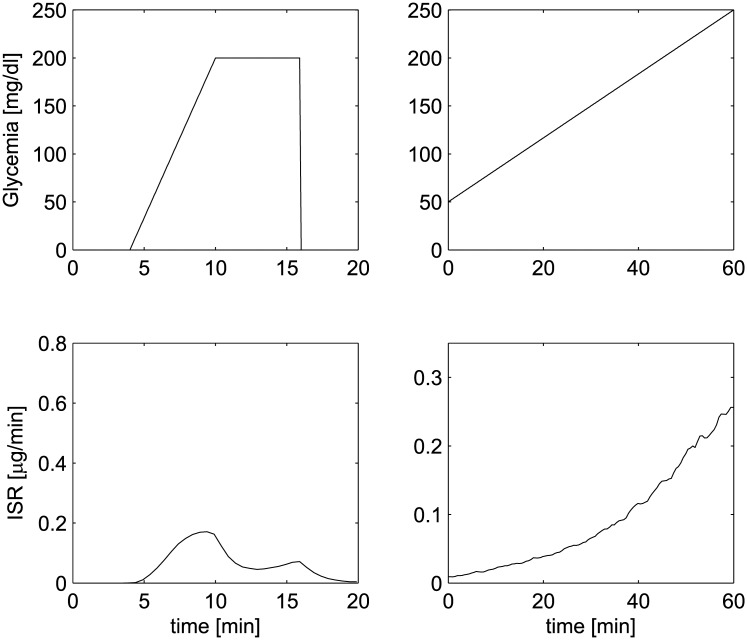
Insulin Secretion Rate when a pattern of increasing glucose concentrations is reproduced, comparable with Grodsky’s fourth and fifth experiments (Figs 4 and 5 in [1]).